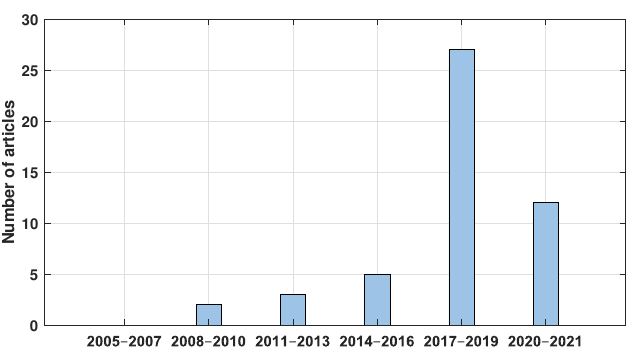
Figure 4. Mosaicing development.